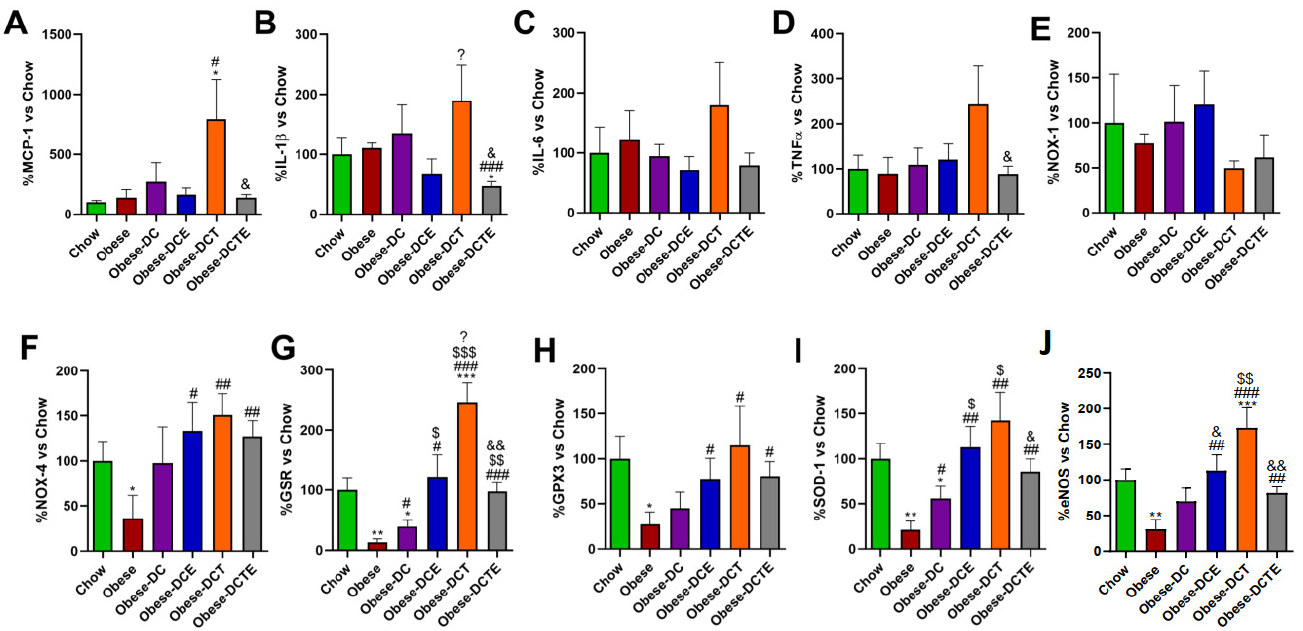
Figure 9. Gene expression of Monocyte Chemotactic Protein-1 ( A ), Interleukin 1 β ( B ), Interleukin 6 ( C ), Tumor Necrosis Factor α ( D ) NADPH oxidase 1 ( E ), NADPH oxidase 4 ( F ), Glutathione Reductase ( G ), Glutathione Peroxidase 3 ( H ), Super Oxide Dismutase 1 ( I ) and endothelial nitric oxide synthase (eNOS) ( J ) in the aorta. Chow = mice fed a standard diet for 25 weeks; Obese = mice fed a high fat (60% kcal from fat)/high sucrose diet for 25 weeks; DC = mice fed a high fat (60% kcal from fat)/high sucrose diet for 23 weeks and switched to a diet with lower caloric intake (25% kcal from fat) for two weeks; DCE = mice fed a high fat (60% kcal from fat)/high sucrose diet for 23 weeks and switched to a diet with lower caloric intake (25% kcal from fat) supplemented with CSAT+ ® for two weeks; DCT = mice fed a high fat (60% kcal from fat)/high sucrose diet for 23 weeks and switched to a diet with lower caloric intake (25% kcal from fat) and subjected to aerobic training for two weeks; DCTE = mice fed a high fat (60% kcal from fat)/high sucrose diet for 23 weeks and switched to a diet with lower caloric intake (25% kcal from fat) supplemented with CSAT+ ® and subjected to aerobic training for two weeks. Values are represented as mean ± SEM; n = 8–10 mice/group. * p < 0.vs chow; ** p < 0.01 vs. chow; *** p < 0.001 vs. chow; # p < 0.05 vs. obese; ## p < 0.01 vs. obese; ### p < 0.001 vs. obese; $ p < 0.05 vs.